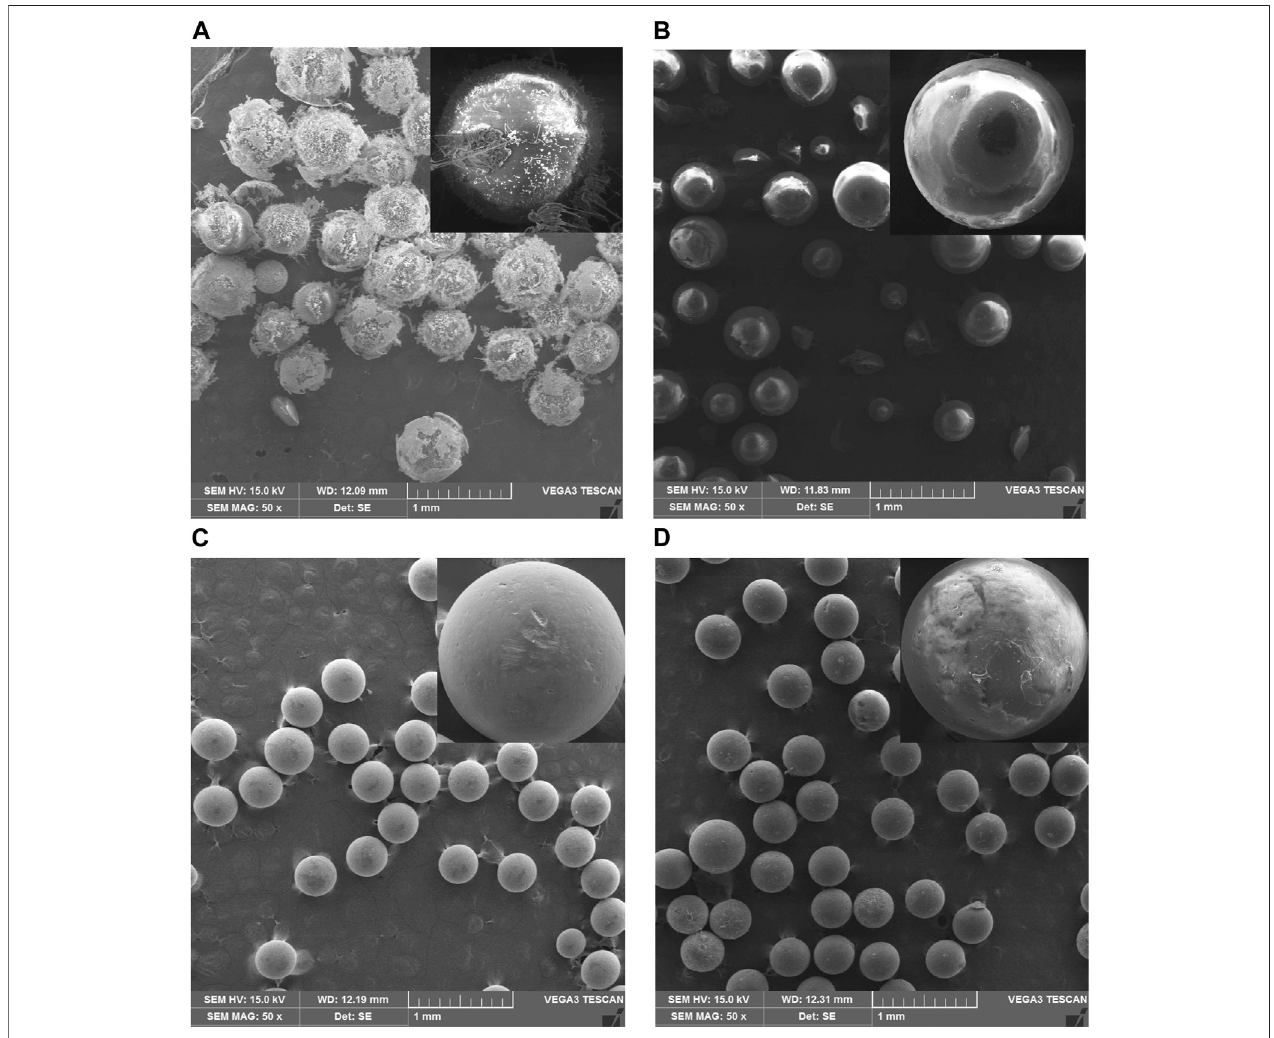
FIGURE 2 | SEM results of (A) XAD-7HP resin without chitosan coating, (B) chitosan-coated XAD-7HP resin after being reacted with Aspergillus niger lipase and glutaraldehyde, (C) MP-64 resin without chitosan coating, and (D) chitosan-coated XAD-7HP resin after being reacted with Aspergillus niger lipase and glutaraldehyde.